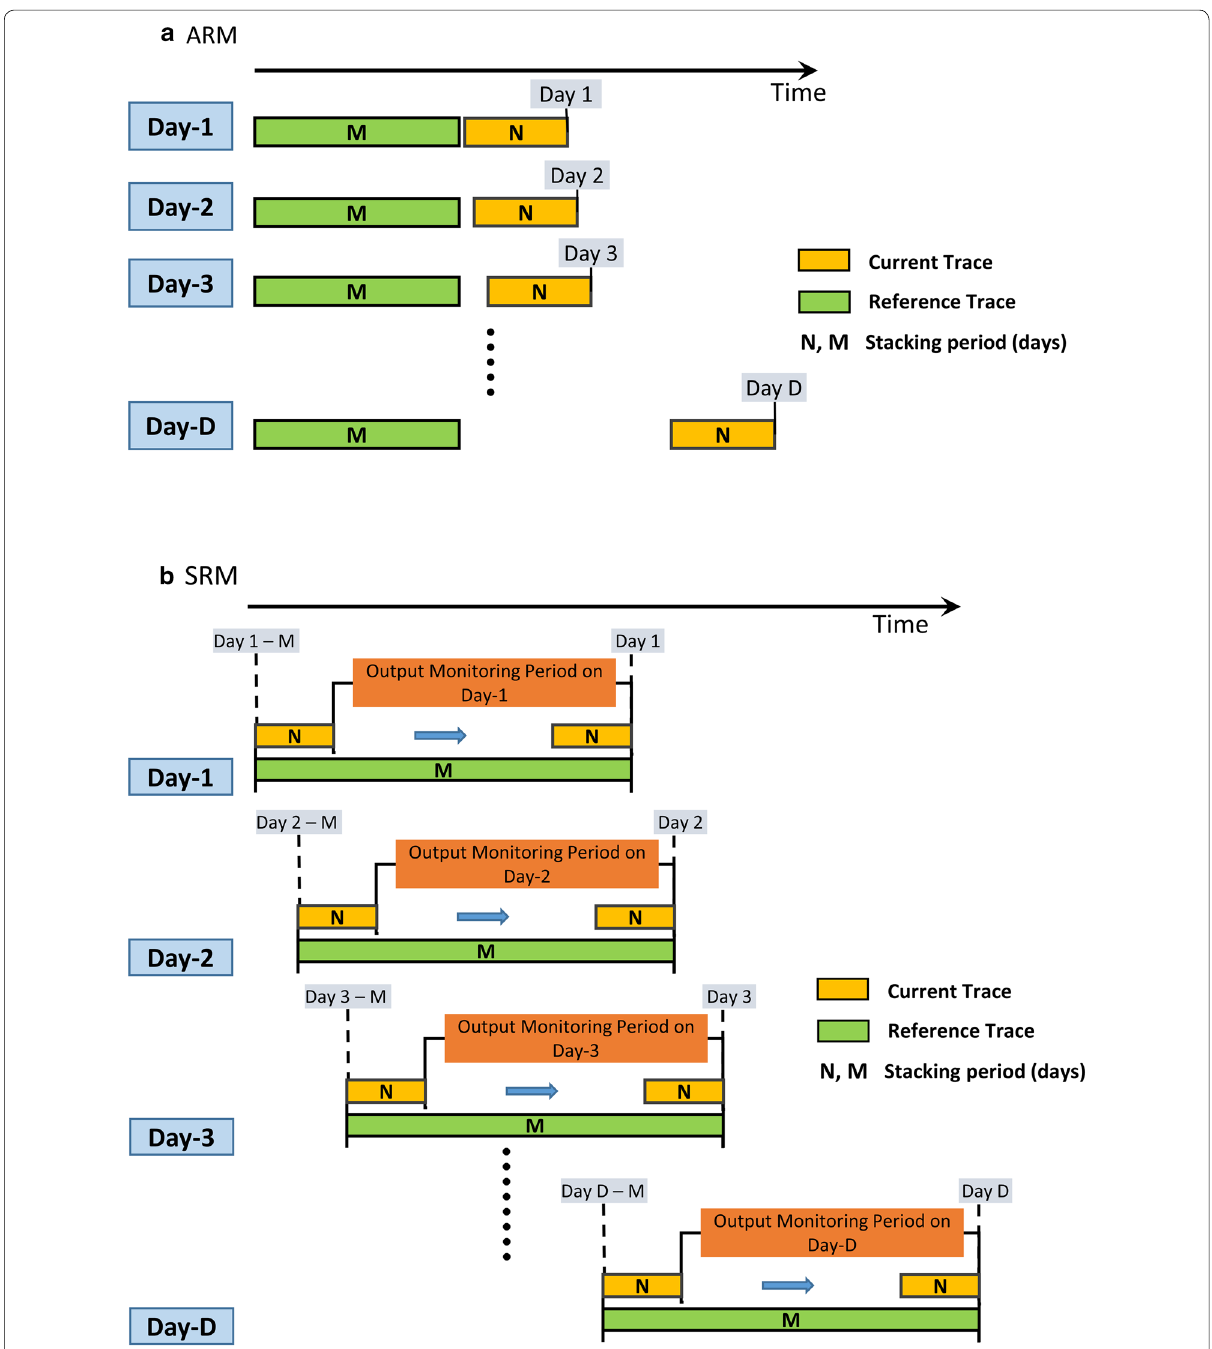
Fig. 3 Schematic representation of estimating temporal velocity variation by a ARM and b SRM. N and M are the stacking periods, in days, for the current and reference trace, respectively. In ARM (panel a), the data period for the new current trace is moved by 1 day while the data period of the reference trace is fixed. In SRM (panel b), the data periods for the reference and current traces are both moved by 1 day, then stretching interpolation is applied for the entire length of the reference trace. In SRM, the current trace data always overlap with the reference